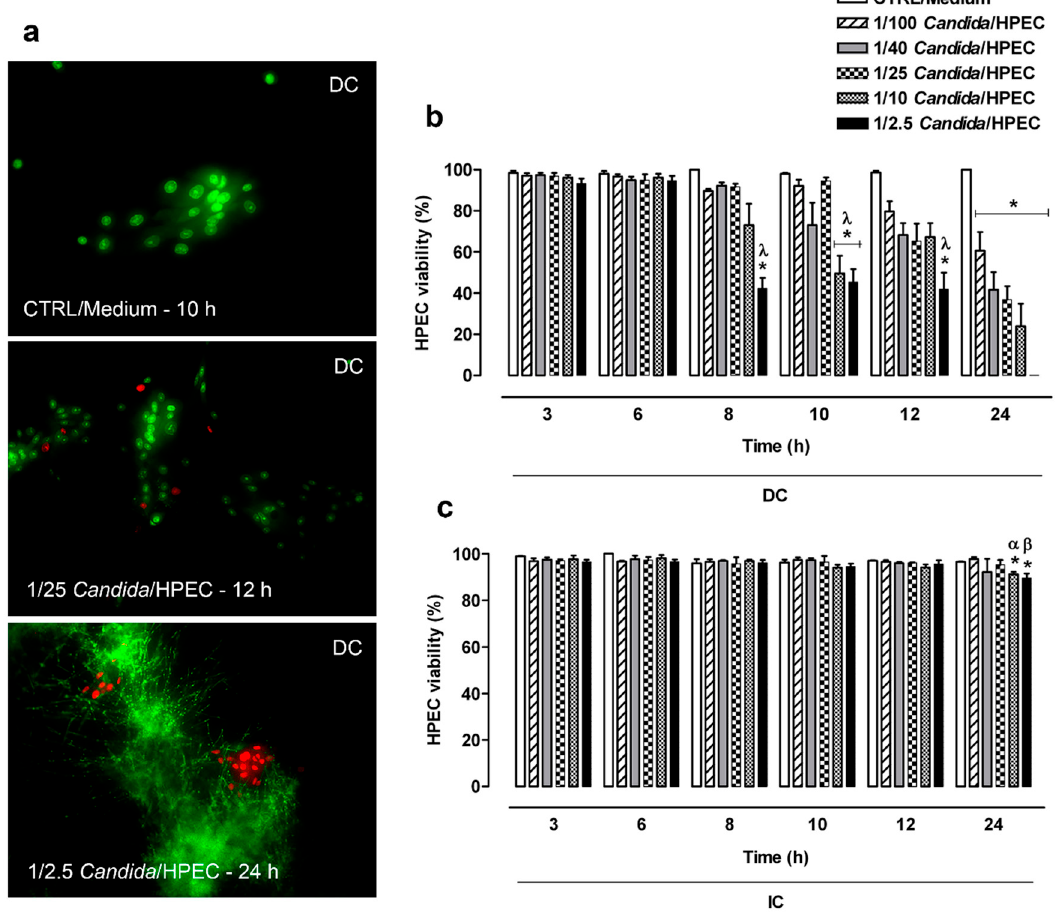
Figure 1. Human palate epithelial cell (HPEC) viability after direct contact (DC) with di ff erent Candida albicans / HPEC ratios (1 / 100 to 1 / 2.5) over time (3–24 h). ( a ) Representative fluorescence images of viable HPECs stained with calcein (green fluorescence, living cells) after direct contact with Candida cells and non-viable HPECs with ethidium bromide linked to DNA (red fluorescence nuclei, dead cells). * Fungus in filamentous form. HPECs cultured in medium (cells unchallenged) served as a control (CTRL / Medium). LIVE / DEAD staining (fluorescence microscope, × 200 magnification). ( b , c ) The number of living cells expressed as percentage of the total cell number was used to establish the quantitative cell viability index. Comparative analysis among di ff erent fungal ratios after DC or indirect contact (IC) over time. (*) p < 0.05 compared to the medium at the same time. ( λ ) p < 0.016 compared to 3 and 6 h. ( α ) p < 0.03 compared to 3, 6, and 8 h. ( β ) p < 0.05 compared to all other times. Results are expressed as the mean ± standard error of the mean (SEM) of at least three independent experiments performed in triplicate with the factorial ANOVA contrast